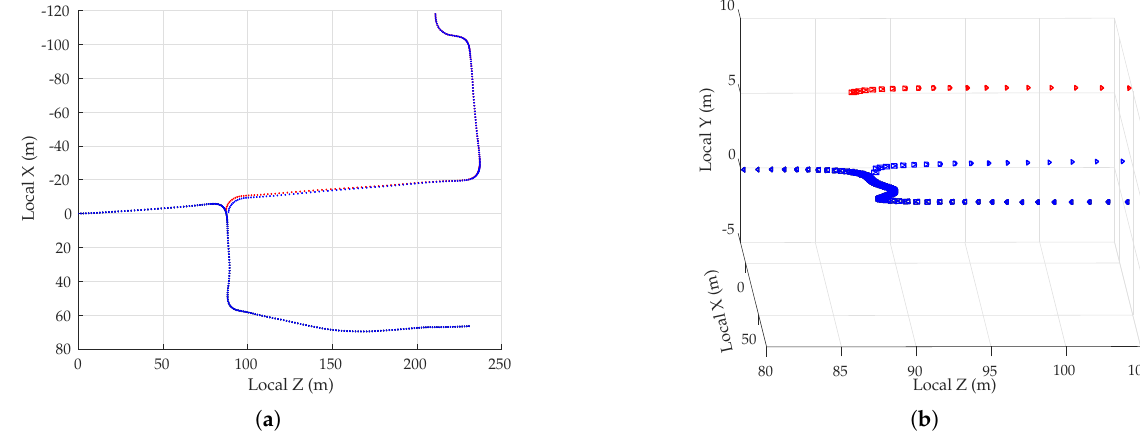
Figure 9. GEOSLAM trajectories post-pose-graph optimization (in blue), overlaid on the corresponding (black and red) trajectories from Figure 8. All keyframes are colored blue at this stage since prior and current keyframes are now connected. ( a ) Top view of the trajectories. Note that the discontinuity at the merge location is smoothly distributed across N m levels of covisibility in the current session, and that the keyframe poses from the prior map are unchanged at this stage. ( b ) View from 5 ◦ elevation. Keyframes from the current trajectory have been adjusted to remove the discontinuity, blue and black keyframes exactly overlap. Not shown: the corresponding map points in the current session are also adjusted to match the updated keyframe